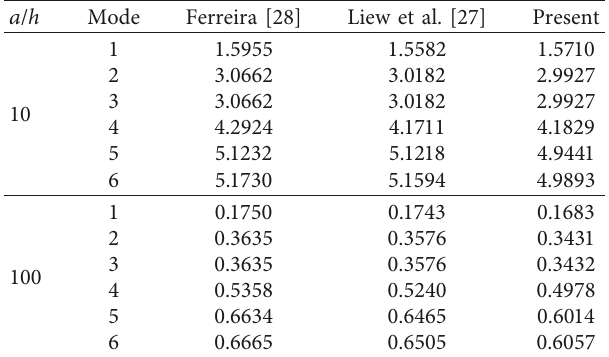
Table 7: Comparison of the nondimensional frequencies of a CCCC plate.